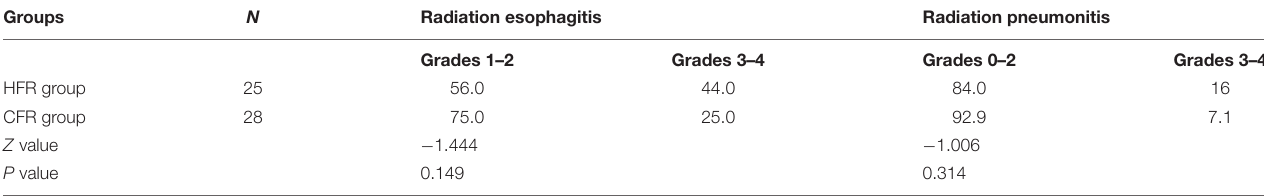
TABLE 2 | Comparison of radiation-induced adverse events.